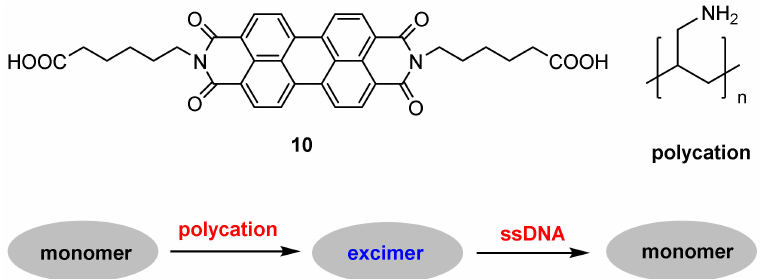
Figure 23. Chemical structures of probe 10 and polycation, and schematic representation for the detection of DNA MTase